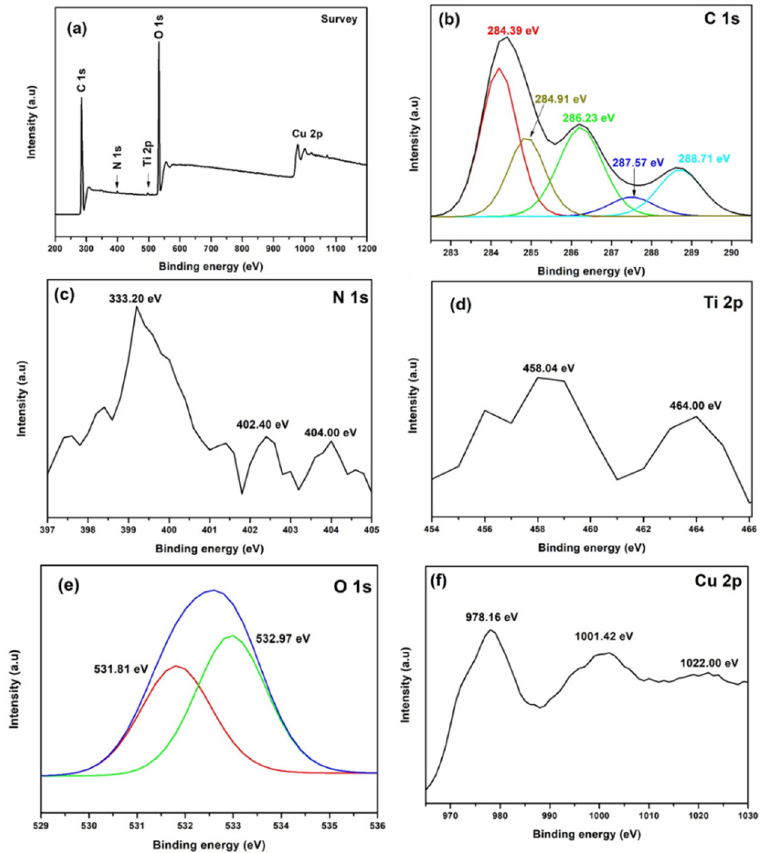
Figure 2. XPS spectra of 1% CuO/TiO 2 @GCN-CA (CTG–500) membrane survey: ( a ) survey, ( b ) C 1s, ( c ) N 1s, ( d ) Ti 2p, ( e ) O 1s and ( f ) Cu 2p spectra.